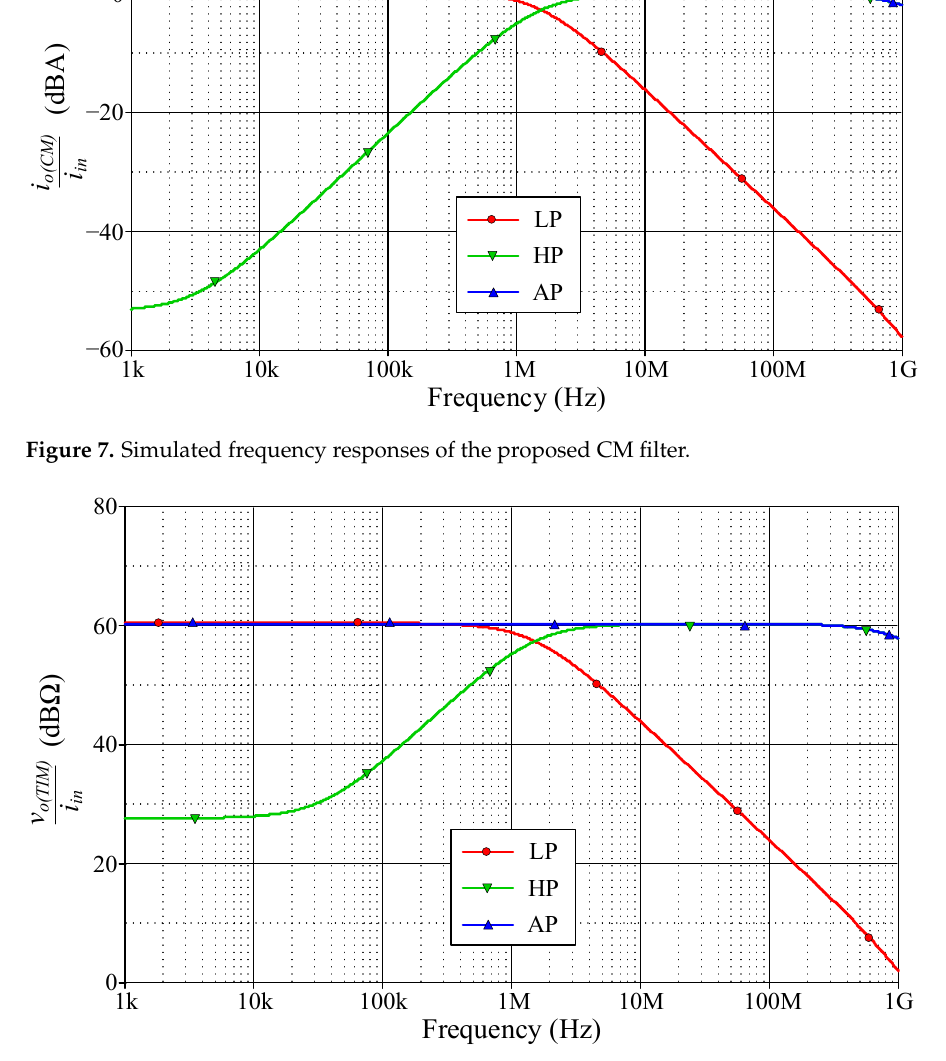
Figure 8. Simulated frequency responses of the proposed TIM filter. Table 4. Simulated f p and percentage errors of the proposed filter in Figure 2.